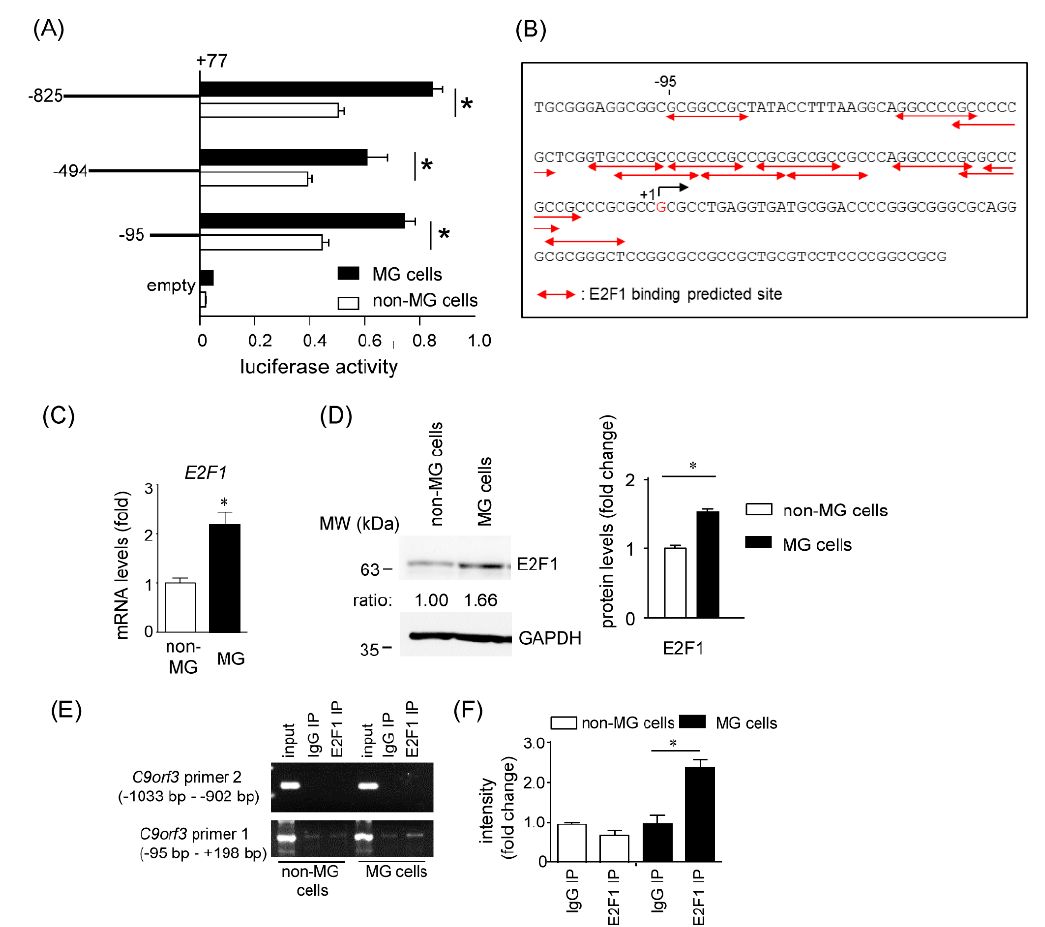
Figure 2. E2F1 regulates C9orf3 promoter activity. ( A ) HCT116 cells were transiently transfected with luciferase reporter plasmids driven by the indicated promoter fragments of C9orf3 for 48 h. Luciferase activities in these cells were measured using the Dual-Luciferase Reporter Assay System. * Significant up-regulation in MG cells compared with non-MG cells. Data are expressed as the mean ± standard deviation (SD; n = 4). * Statistically significant difference versus non-MG cells (unpaired Student’s t -test, p < 0.05). ( B ) Nucleotide sequence of the 5’-flanking region of the C9orf3 gene. Putative binding sites for E2F1 are indicated with bent arrows in red based on the PROME. ( C ) E2F1 mRNA levels were measured by RT-qPCR using the indicated primer sets. Data are expressed as the mean fold changes ± standard deviation (SD; n = 4), compared with those in the non-MG cells. * Statistically significant difference versus non-MG cells (unpaired Student’s t -test, p < 0.05). ( D ) Amounts of E2F1 proteins in the non-MG cells and MG cells were measured by western blotting using glyceraldehyde-3-phosphate dehydrogenase (GAPDH) as a loading control. The results of western blotting using anti-E2F1 antibody from three independent experiments were quantified by densitometry as shown in ( D ). Data are expressed as the mean ± standard deviation (SD; n = 4). * Statistically significant difference versus non-MG cells (unpaired Student’s t -test, p < 0.05). ( E , F ) HCT116 cells were subjected to chromatin immunoprecipitation (ChIP) assays. Formaldehyde-crosslinked nuclear extracts were immunoprecipitated with an anti-E2F1 antibody or normal rabbit IgG (IgG). PCR was performed using an input nuclear chromatin fraction as a template (input). Specific PCR products corresponding to the region of the C9orf3 promoter containing E2F1-binding sites were amplified and separated by agarose gel electrophoresis followed by ethidium bromide staining. The results of ChIP with an anti-E2F1 antibody from three independent experiments were quantified by densitometry as shown in ( F ). Data are expressed as the mean ± standard deviation (SD; n = 4). * Statistically significant difference versus control (IgG) (unpaired Student’s t -test, p < 0.05). MW, molecular weight.